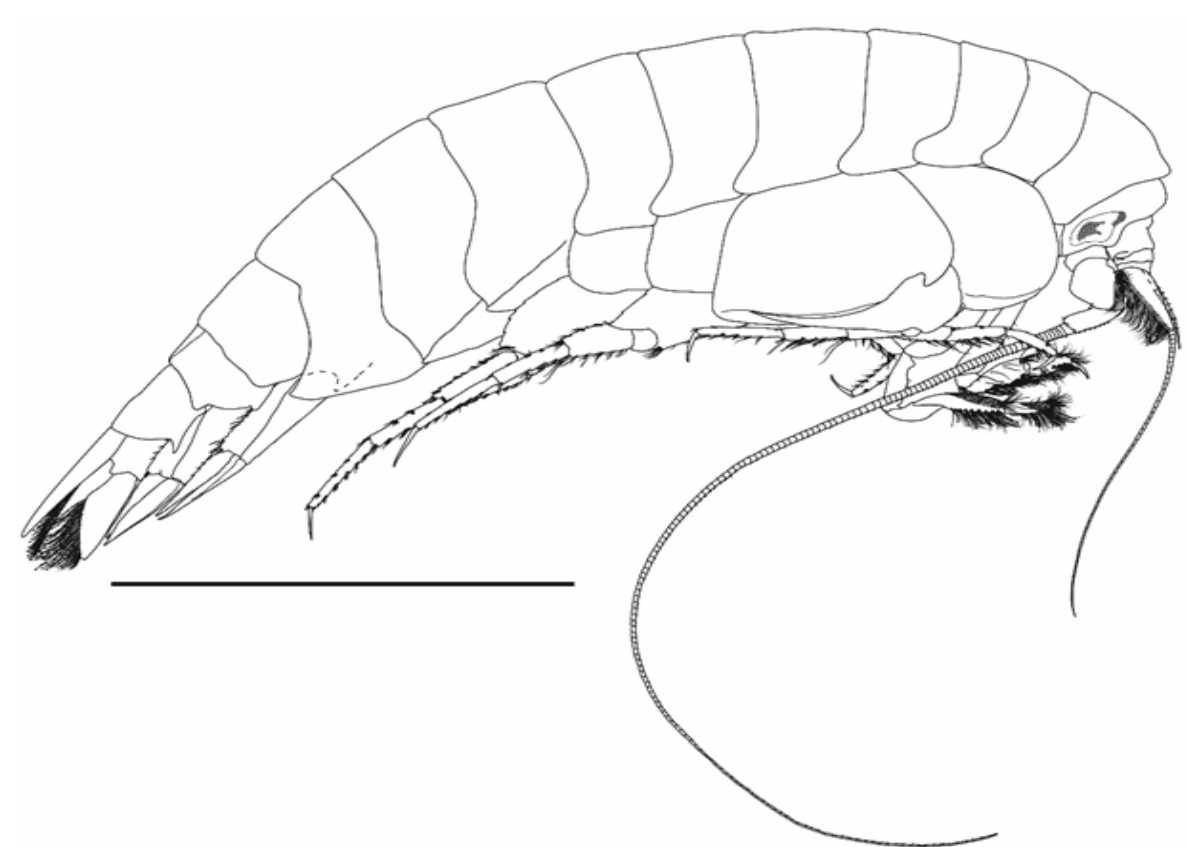
Figure 1. Cyphocaris boecki sp. nov., female holotype, 33.3 mm (MOUFPE 20068). Habitus. Scale bar: 10 mm. Gnathopod 1 (Figure 4A) coxa is subtrapezoidal, ventral margin is convex; basis is 7.2 × longer than wide, posterodistal corner has three slender setae; ischium posterodistal corner has a row of nine setae; merus has a distal blunt projection facially, posterior margin has a row of setae; carpus is 1.8 × longer than wide, with two facial rows of setae, ventral margin setulose; propodus is about 0.8 × the length of the carpus, with three facial rows of setae, posterior margin is serrated; palm is extremely acute, with a robust seta defining palm; dactylus outer margin with a proximal seta, inner margin serrate. Gnathopod 2 (Figure 4B) coxa is subtriangular and is 1.7 × deeper than broad; basis is 6.1 × longer than wide, elongate and curved backwards; ischium is 3.6 × longer than wide, anterior margin has seven setae; merus is about 0.7 × the length of the ischium; carpus is 4.2 × longer than wide, anterofacially setulose, anterior margin has a distal row of 11 setae, posterior margin with nine rows of setae; propodus is about half the length of the carpus, anterofacially setulose, anterior margin with a distal dense tuft of setae, and posterior margin has proximal setules and eight rows of setae; palm is acute, defined by the sudden change in angle to the posterior margin; dactylus is broad, bifid, outer margin has one proximal and one distal seta, and inner margin is distally